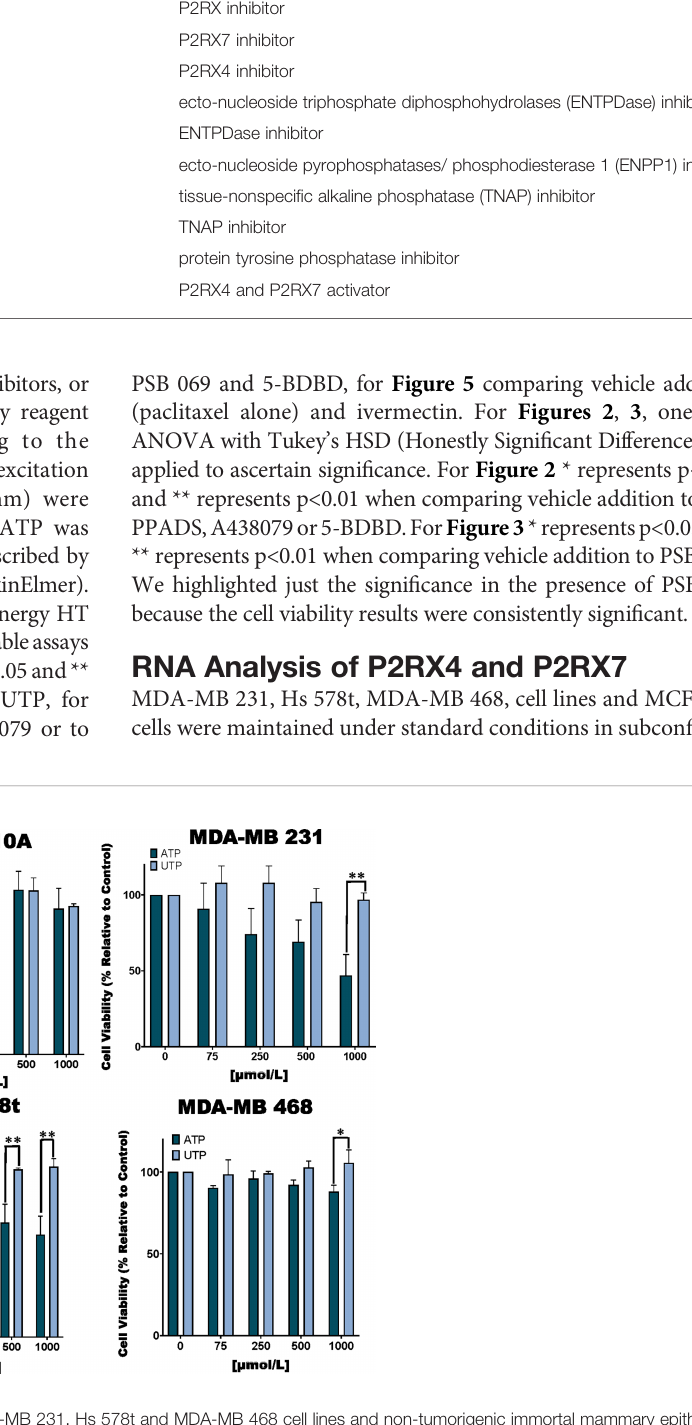
FIGURE 1 | Cell viability of ATP and UTP-treated cells. TNBC MDA-MB 231, Hs 578t and MDA-MB 468 cell lines and non-tumorigenic immortal mammary epithelial MCF-10A cells were treated for 48 hours with increasing concentrations of ATP or UTP, and cell viability was measured with the PrestoBlue HS assay. Error bars represent standard deviations calculated from three independent experiments performed in triplicate. The student ’ s t-test was applied to the to ascertain signi fi cance. * represents p < 0.05 and ** represents p < 0.01 when comparing ATP to UTP.